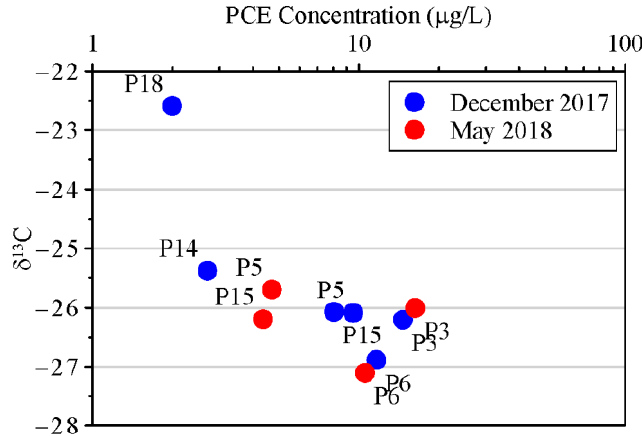
Figure 10. Results of CSIA analyses. Sampling campaigns of December 2017 and May 2018.